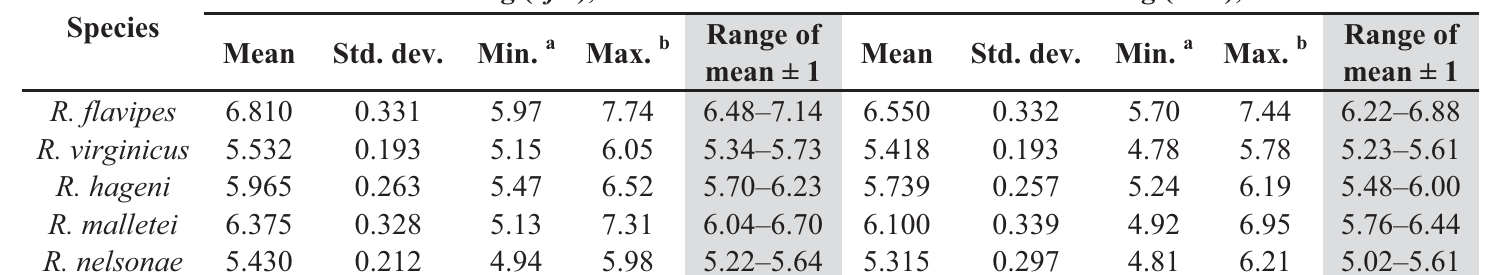
Note: Shaded boxes represent values that were used in building the dichotomous key for soldiers and